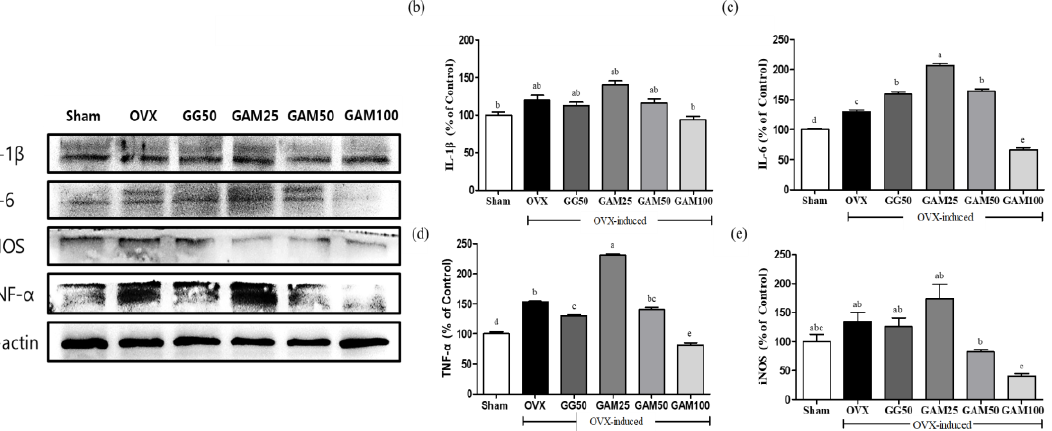
Figure 3. Effects of GAM on inflammation markers in OVX-induced rat models. The effects of GAM on ( a ) the protein expression of inflammatory mediators were evaluated using Western blot analysis and the levels of ( b ) IL-1 β , ( c ) IL-6, ( d ) TNF- α , and ( e ) iNOS. a–e Mean values with different letters differed significantly ( p < 0.05) among groups, as shown by Tukey’s test.